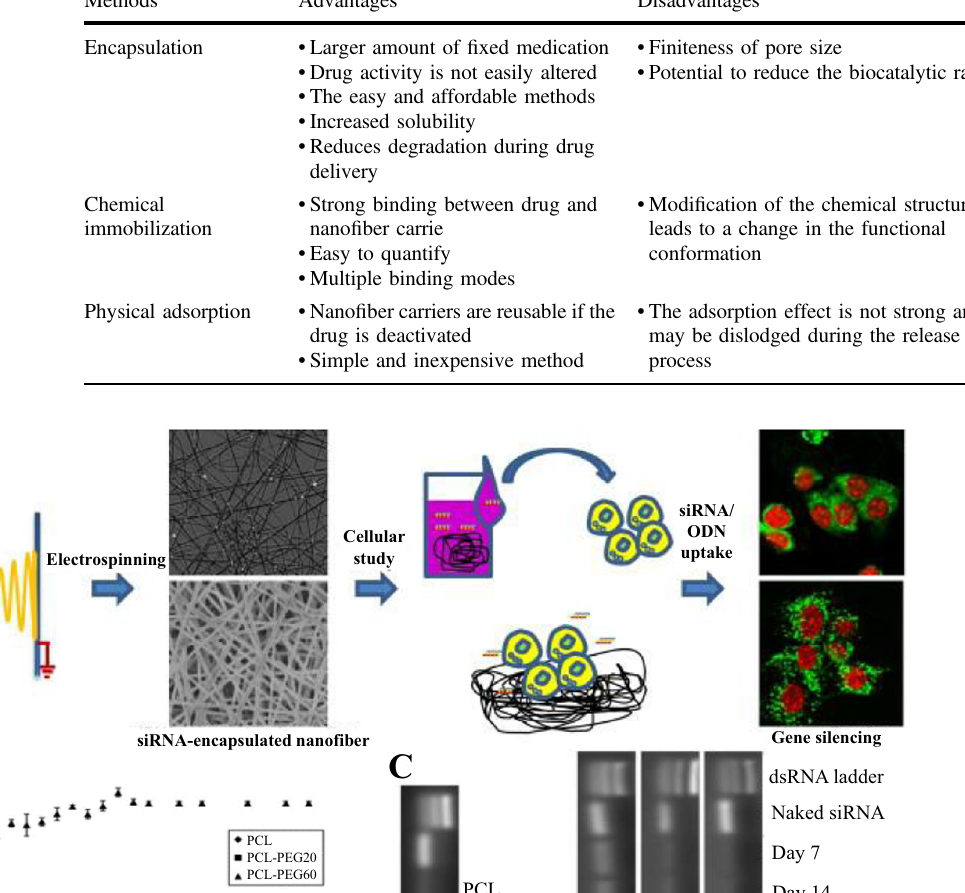
Table 1 Advantages and disadvantages of each drug loading method